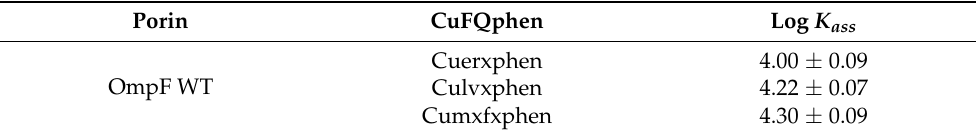
Figure 3. Plot of the Response Units (R.U.) at the equilibrium (t = 175 s) vs. the concentration of Culvxphen. K d was calculated with the non-linear fit of the one-site direct binding equation. Data points are a mean of, at least, three individual experiments. Error bars are the SD. Table 3. Values of the association constants ( K ass ) of OmpF-compounds, determined with OmpF WT/ E. coli total extract proteoliposomes, by SPR, using Equation (5). The presented values are the mean of, at least, three independent experiments (±SD).